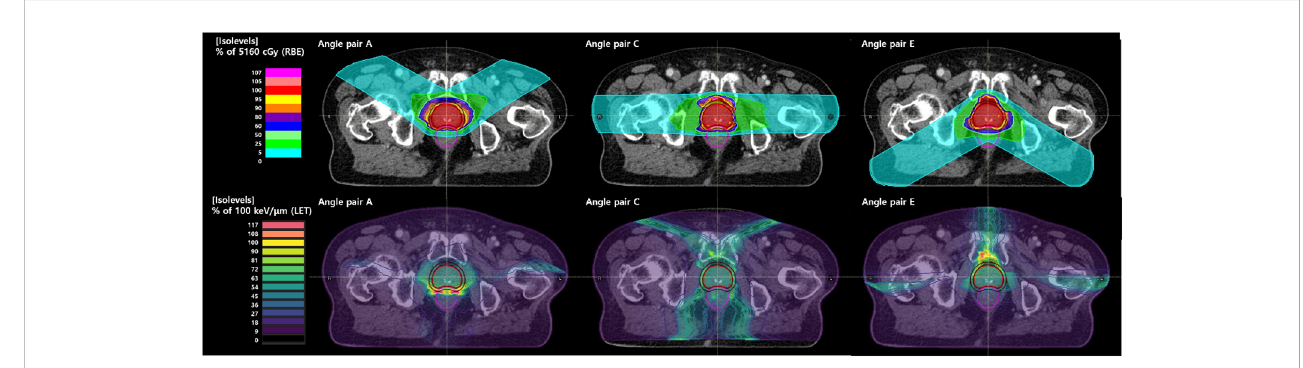
FIGURE 3 LET distributions of angle pair (A, C, E).